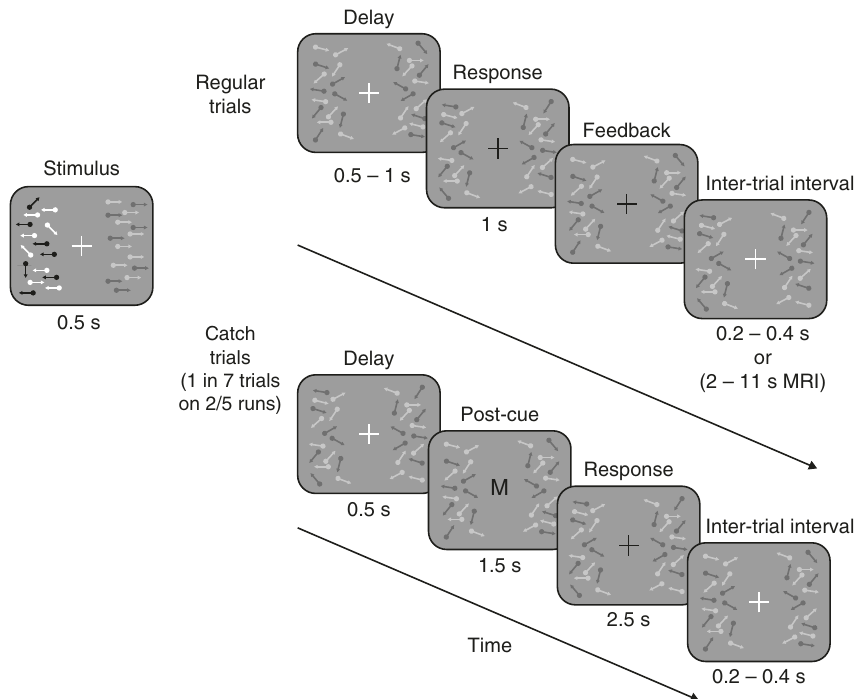
Fig. 1 Behavioral task. Observers discriminated which of two random dot stimulus patches had higher contrast or coherence in different blocks of trials. Each block began with the word “ contrast ” or “ motion ” indicating that observers should report about contrast or coherence, respectively, and ignore the other feature. Between trials (Inter-trial interval) and during all but the Stimulus segment, the dot patches were presented at 25% contrast with incoherent motion. On each trial, both dot patches increased by independent base increments of contrast and coherence ( + 7.5, + 15, + 30, or + 60% contrast; + 15, + 30, + 45, or + 60% coherence) for 0.5 s (Stimulus). In addition, for each feature one side was chosen independently to have an additional threshold-level increment, determined by a staircasing procedure. For regular trials, after a 0.5 – 1-s period (Delay), observers were asked to report which side contained